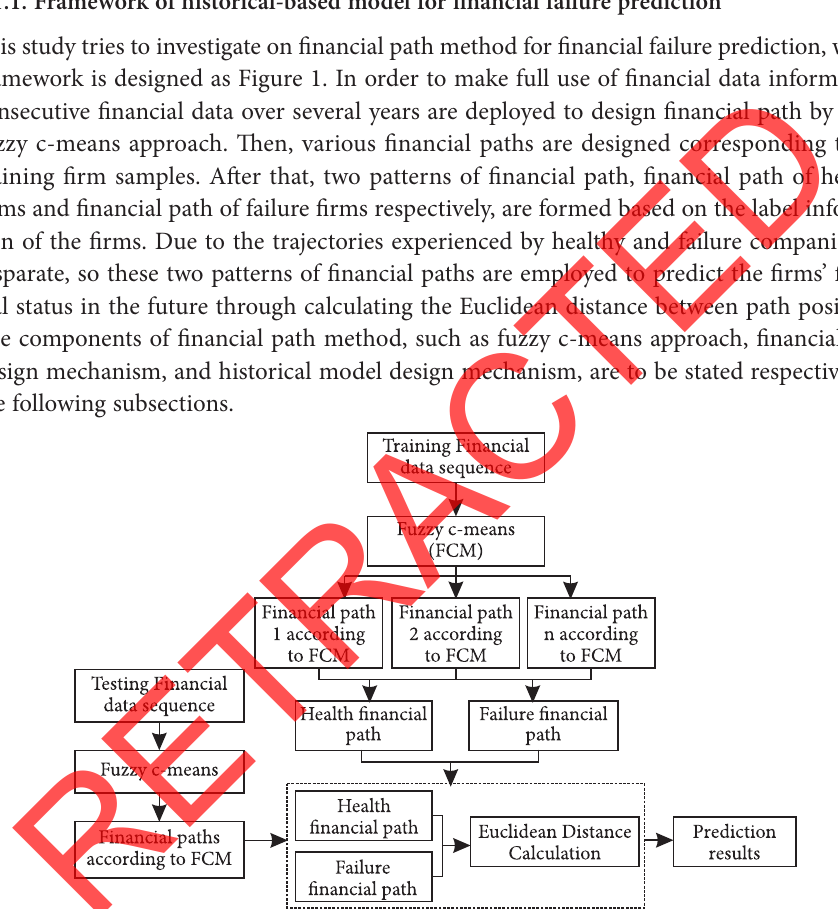
Figure 1. Framework of historical-based model for financial failure